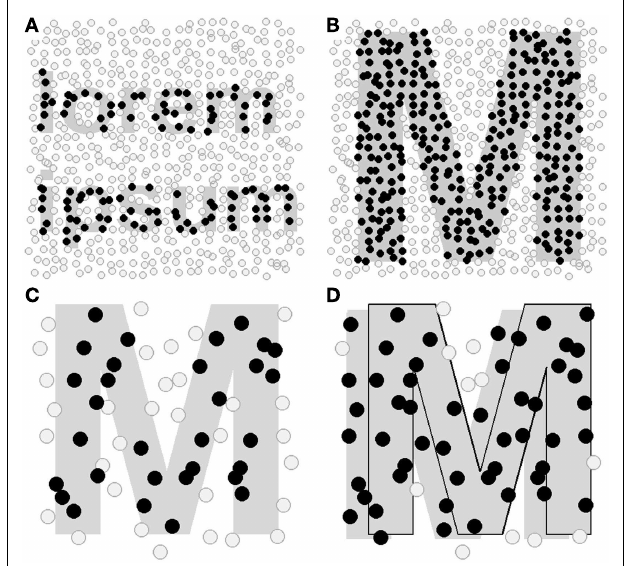
FIGURE 1 | Representation of lorem ipsum (A) and M (B) by a random grid of 25 × 25 “phosphenes.” Circles show the phosphene locations and are filled to show the phosphenes that would be activated to represent the stimulus shown by the gray mask. Only the black circles, not the gray mask or gray circles, would be evident in the prosthetic image. In a single frame, the two words lorem ipsum cannot be reliably represented, but the single letter M is easily represented. Note that if the camera (i.e., the patient’s eye or head) moves with respect to the text, different sets of electrodes will be activated, making some phosphenes turn on and off.With an 8 × 8 grid of phosphenes, stable single letters can be reliably represented (C) , however, if the letters are not stabilized with respect to head or eye movements, even single letters may become unrecognizable. In (D) , the M has been replicated and overlaid to the right by 10% of its width, mimicking motion blur due to a small camera movement. As the majority of electrodes would now be activated, it is difficult to identify the letter from this pattern. Therefore presenting a single spatially stabilized letter is the ideal compromise when spatial resolution is